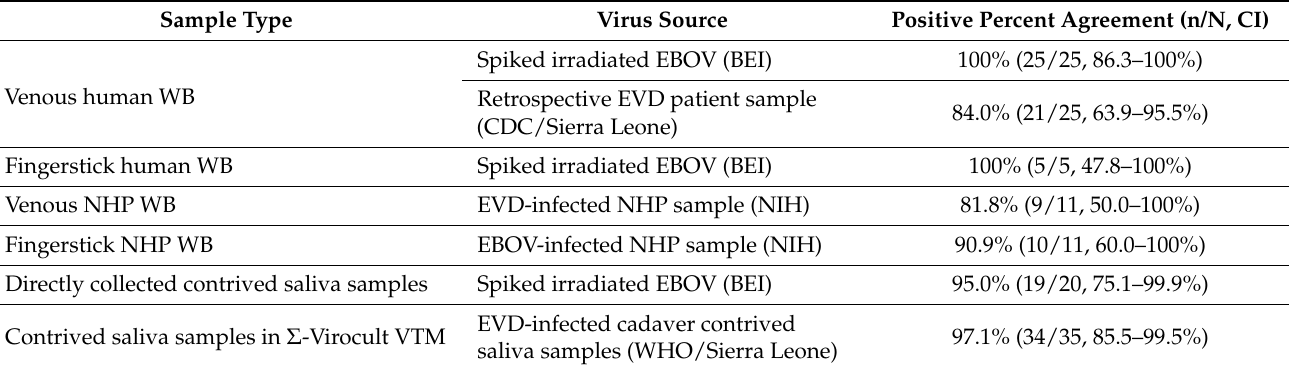
Table 2. Sensitivity performance of the OraQuick ® Ebola Rapid Antigen